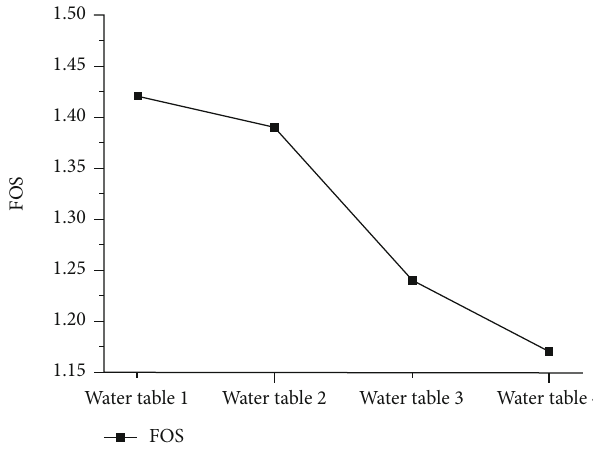
Figure 12: FOS versus di ff erent water